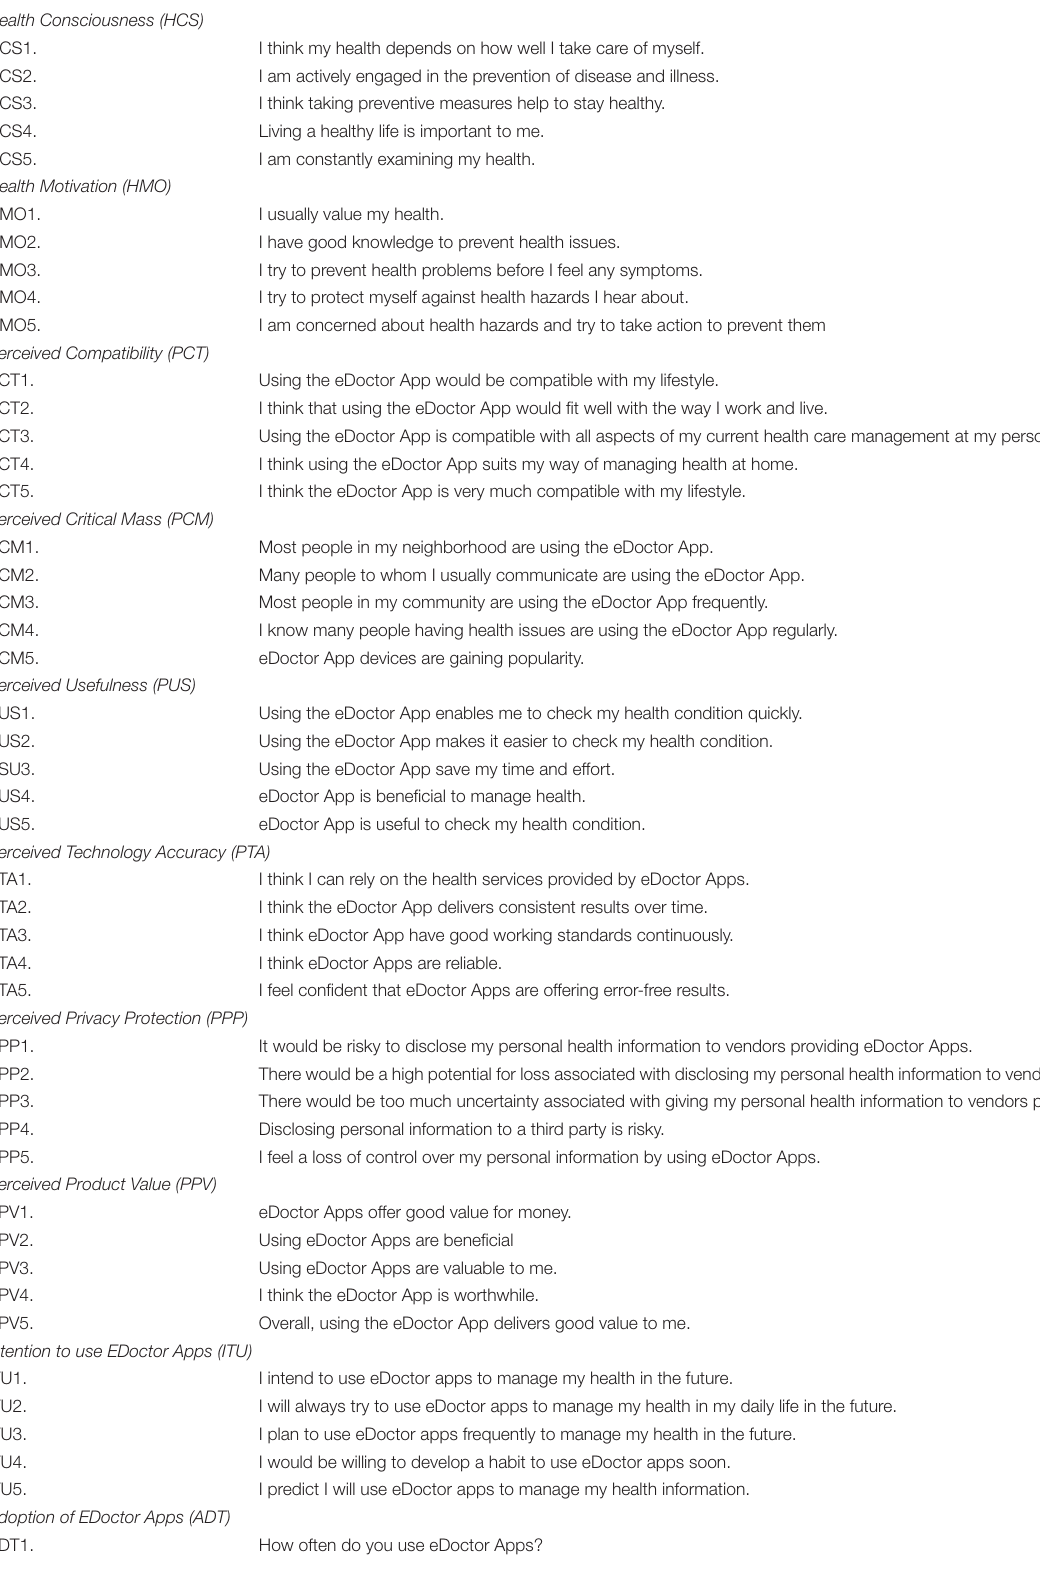
TABLE A1 | Survey